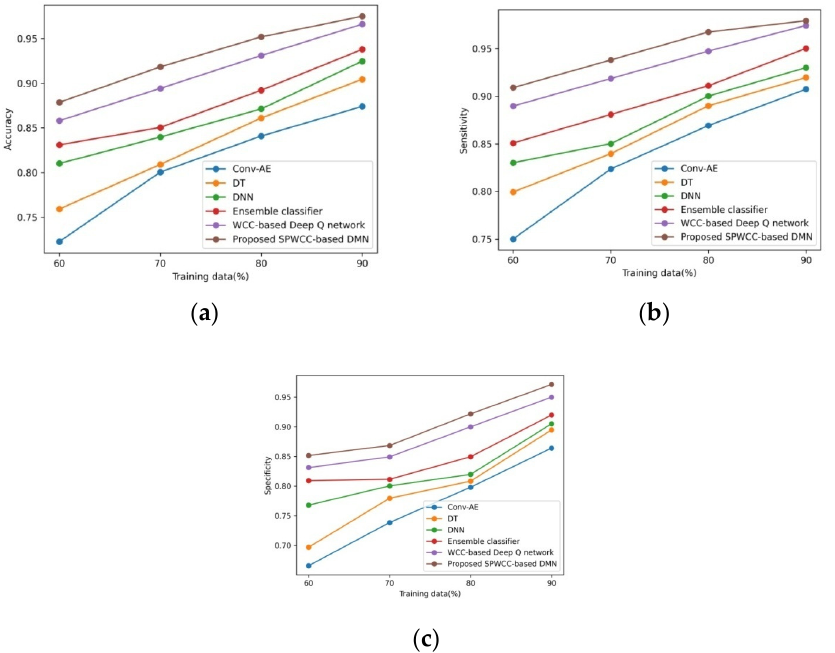
Figure 7. Assessment of techniques with other attacks considering ( a ) accuracy, ( b ) sensitivity, and ( c ) specificity. ( c )